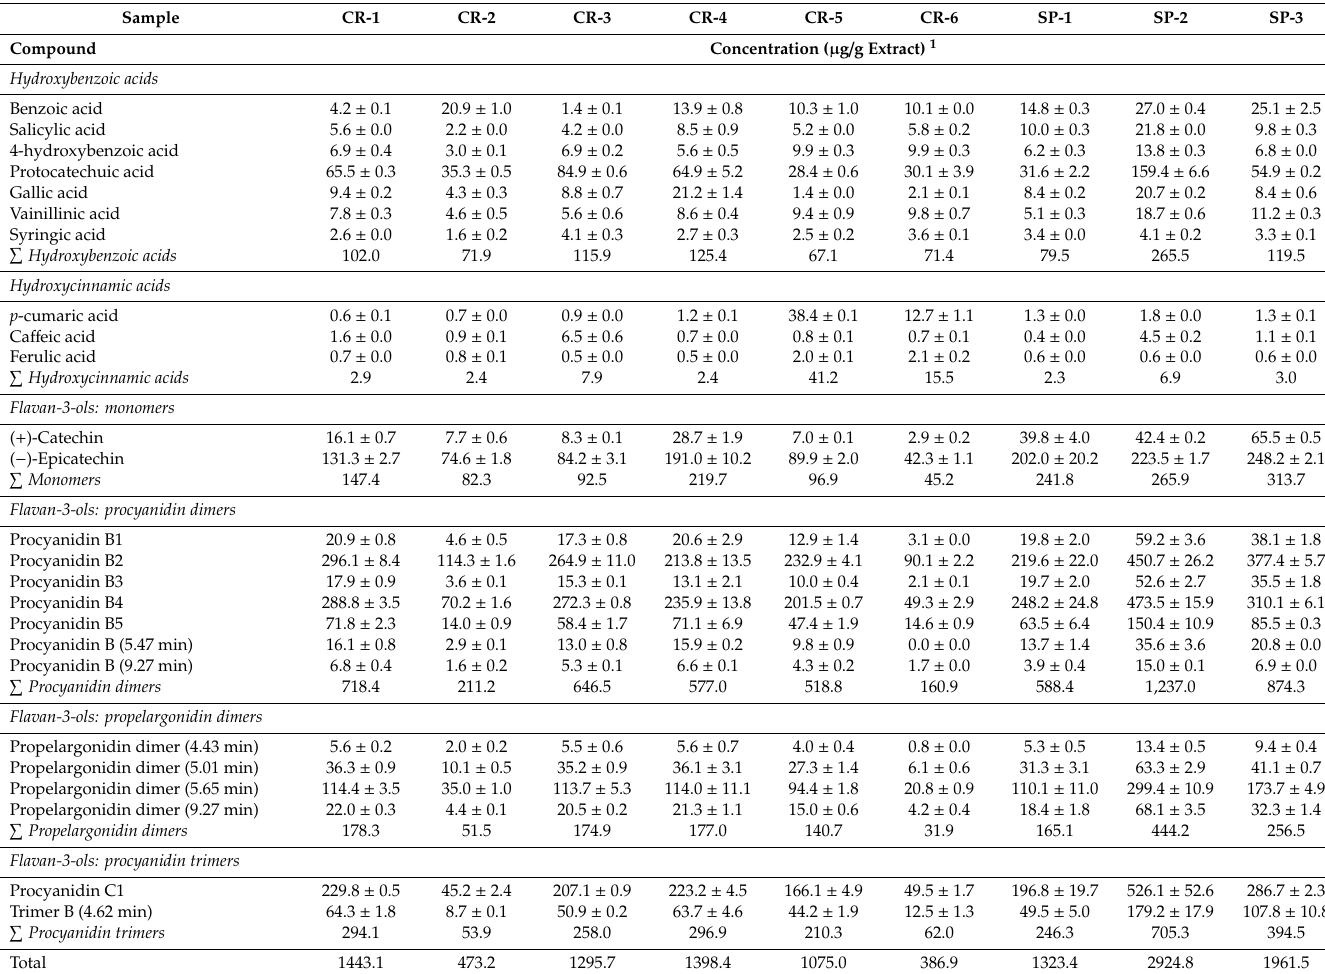
Table 5. Phenolic composition of U. tomentosa bark commercial